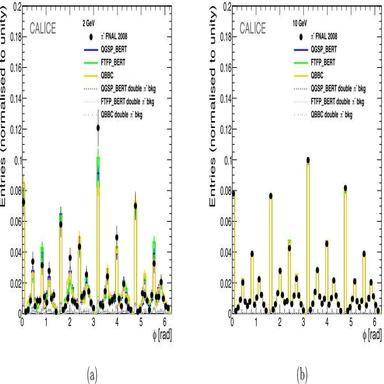
The polar angle of secondary tracks for energies of 2 GeV (a) and 10 GeV (b) of the incoming −-mesons. Other details follow those of.